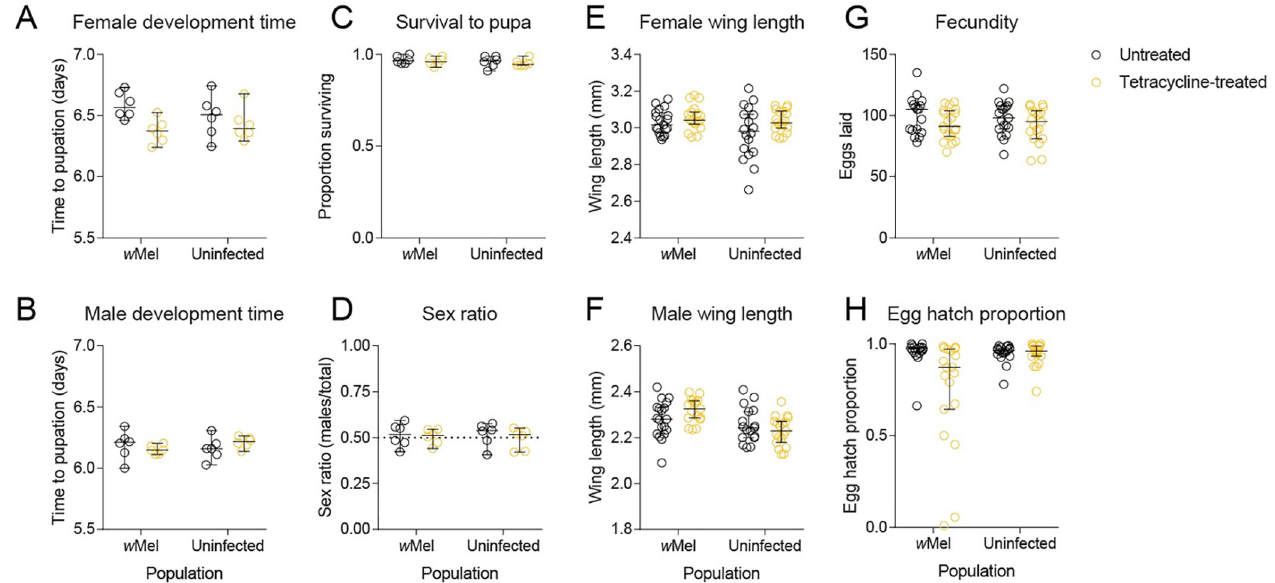
Fig 4. Phenotypic effects of parental tetracycline treatment in Aedes aegypti . w Mel-infected mosquitoes or uninfected mosquitoes were left untreated or fed 2 mg/mL tetracycline. Their offspring were measured for (A) female and (B) male development time, (C) survival to pupa, (D) pupal sex ratio, (E) female and (F) male wing length, (G) fecundity and (H) egg hatch. Dots represent data from replicate trays (A-D) or individual mosquitoes (E-H). Lines and error bars represent medians and 95% confidence intervals in all panels.